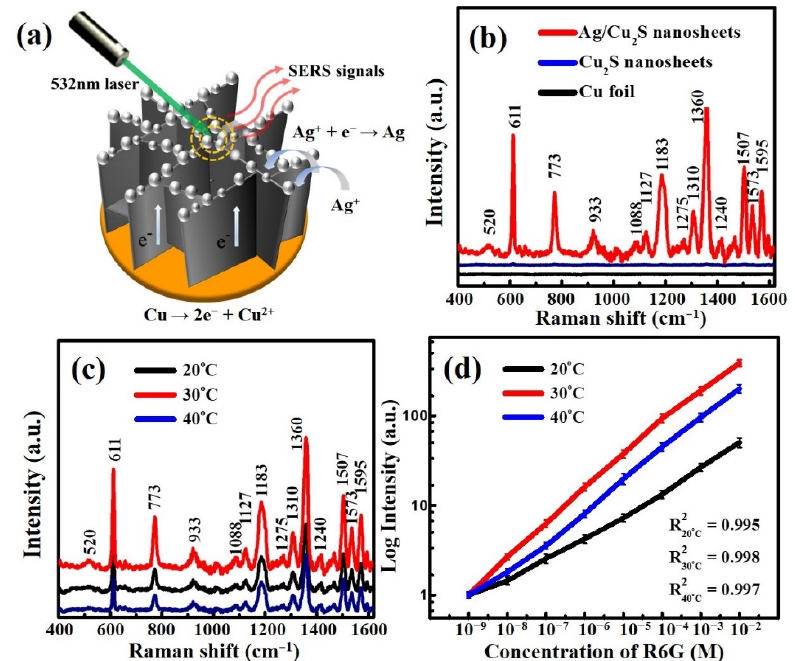
Figure 2. ( a ) Illustration of SERS sensing of Ag/Cu 2 S nanosheets for detection of rhodamine 6G (R6G) dye molecule. ( b ) SERS spectra of R6G dye adsorbed on three different substrates: Cu foil, Cu 2 S, and Ag/Cu 2 S nanosheets. ( c ) SERS spectra of R6G using Ag/Cu 2 S prepared at different temperatures of 20, 30, and 40 ◦ C. ( d ) Linear correlation between the concentration of R6G and the intensity of characteristic SERS peak at different immersed temperatures of 20, 30, and 40 ◦